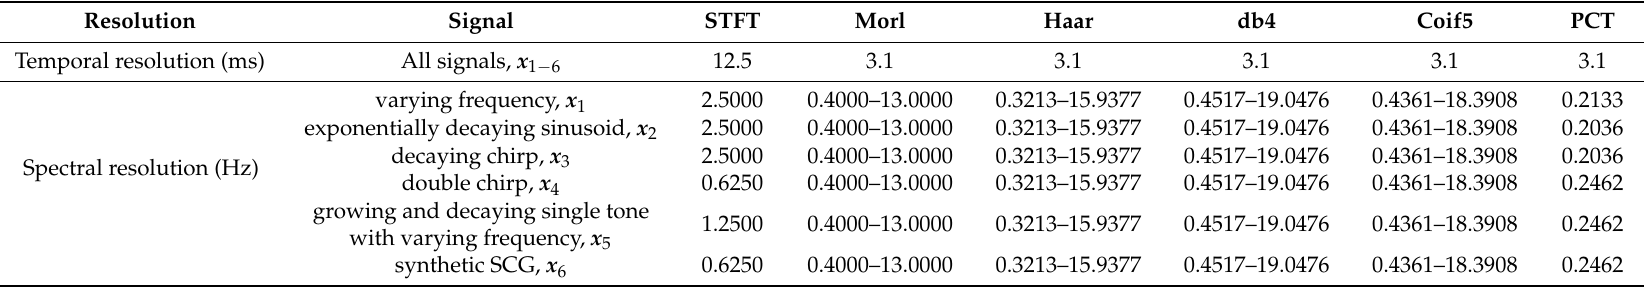
Table 3. Temporal and spectral resolution for different signals and TFD for frequencies between 10 and 70 Hz. The resolution of TFD was optimized to minimize the NRMSE for each synthetic signal. STFT tended to have coarser temporal and spectral resolution compared to PCT. Frequency resolution for CWT-based methods is given as a range with lower values corresponding to lower frequencies.